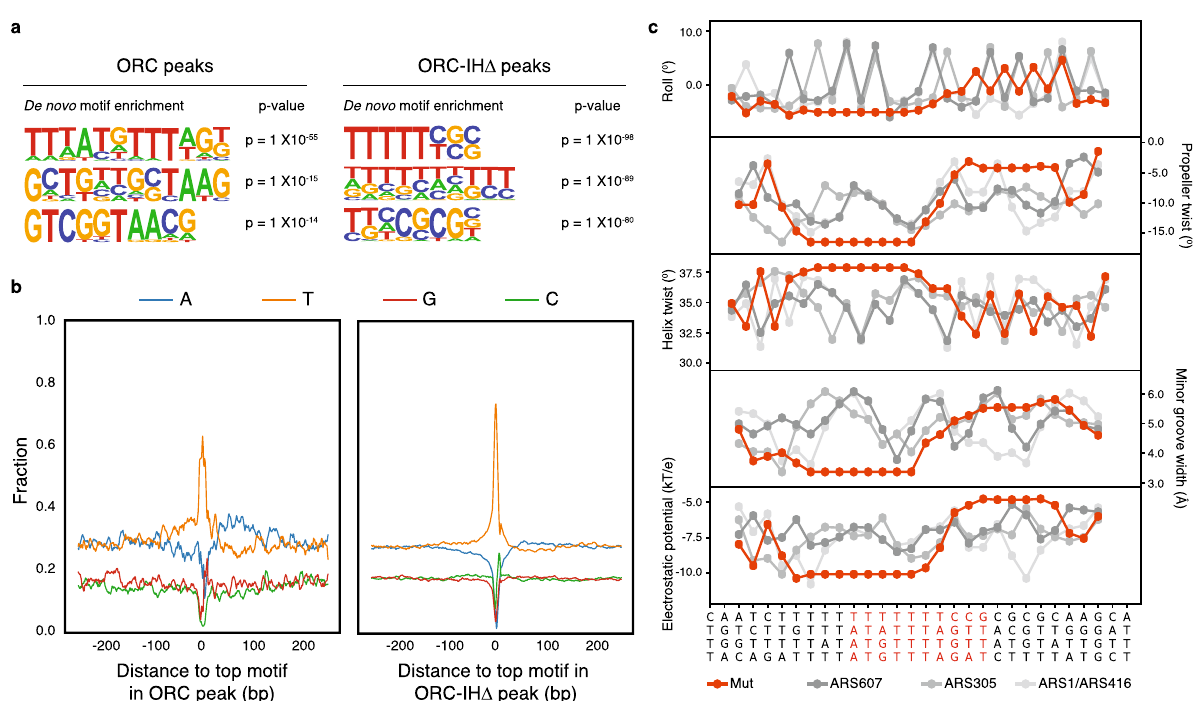
Fig. 4 WT and mutant ORC possess differential binding af fi nities to distinct DNA sequences. a De novo motif analyses reveal distinct sequences enriched in WT ORC (left) and ORC-IH Δ (right) peaks. The top three most signi fi cantly enriched sequences are shown. P values are calculated by binomial test using randomly selected genomic regions as background. b Base composition analysis of top motif within WT and Orc4-IH Δ ORC ChIP-seq peaks shows the fraction of each base. Motifs are organized in the same orientation and position 0 denotes the fi rst base of the particular sequence. A signi fi cant enrichment of poly-T and poly-A was detected upstream and downstream of the motifs, respectively. c High-throughput prediction of different structural shape parameters of DNA between TTTTTTTCCGCG motif and three known ACSs from ARS607, ARS305, and ARS1. Shape features include minor groove width (MGW), propeller twist (ProT), helix twist (HelT), electrostatic potential (kT/e), and Roll. HelT and Roll describe rotation angles between adjacent base pairs. ProT describes a rotation angle between two bases that form a base